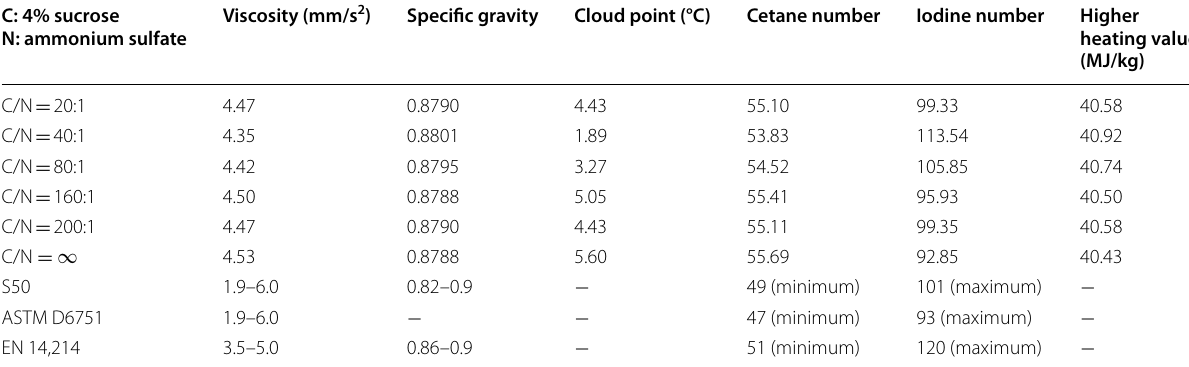
Table 3 Comparison of the properties of biodiesel for lipid by R-ZL2 fermented with different C/N ratios